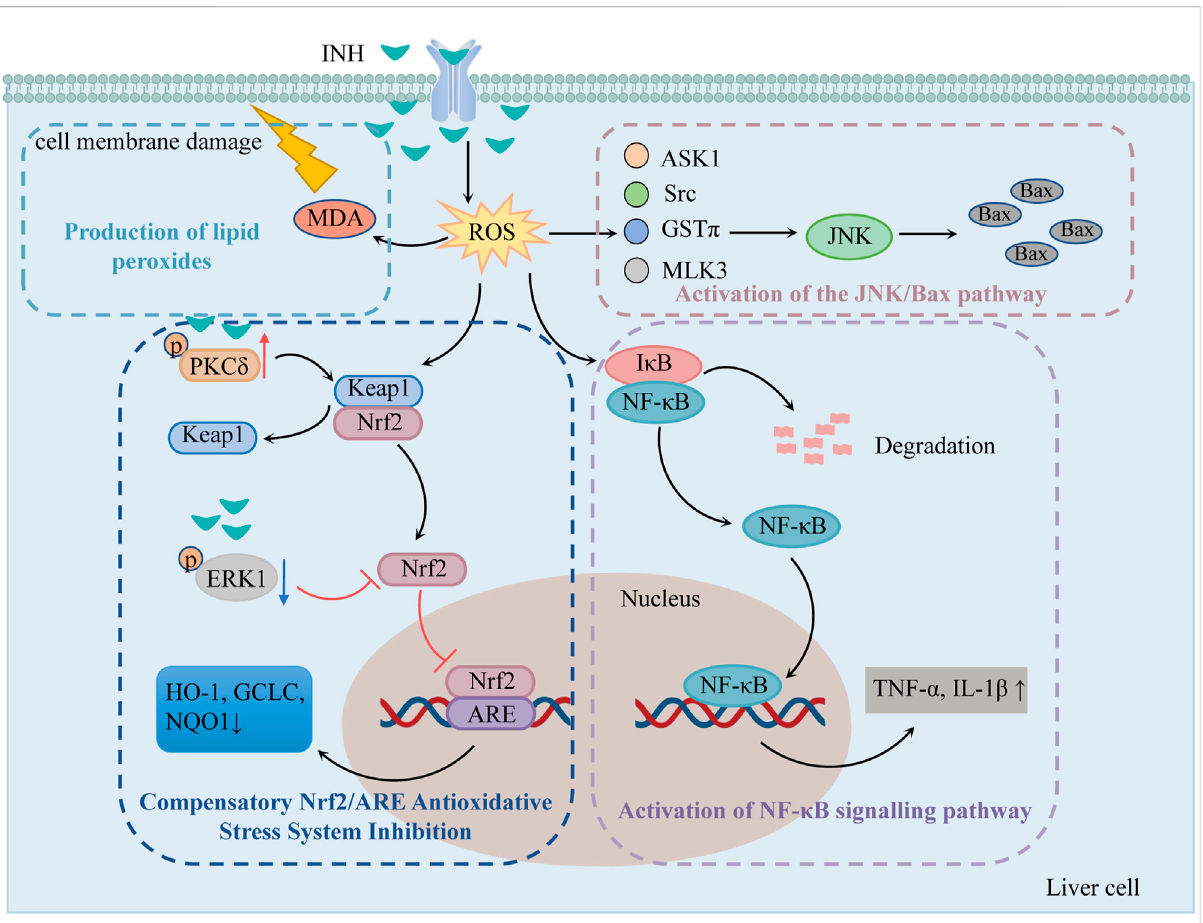
FIGURE 1 The mechanisms of oxidative stress injury caused by INH (Compensatory Nrf2/ARE antioxidative stress system inhibition, production of lipid peroxides, activation of NF- κ B signaling pathway and the JNK/Bax pathway play important roles in INH-induced oxidative stress injury). Notes: INH, isoniazid; ROS, reactive oxygen species; MDA, malonic dialdehyde; Nrf2, nuclear erythroid 2-related factor 2; Keap1, kelch-like ECH-associated protein 1; PKC δ , protein kinase C δ ; ERK1, extracellular signal-regulated protein kinase 1; ARE, antioxidant response element; HO-1, heme oxygenase 1; GCLC, glutamine- L -cysteine ligase; NQO1, quinone oxidoreductase 1; NF- κ B, nuclear factor- κ B; I κ B, NF- κ B inhibitory protein; JNK, c-jun N-terminal kinase; ASK1, apoptosis signal-regulating kinase 1; Src, Src kinase; GST π , glutathione S-transferase π ; MLK3, mixed-lineage protein kinase